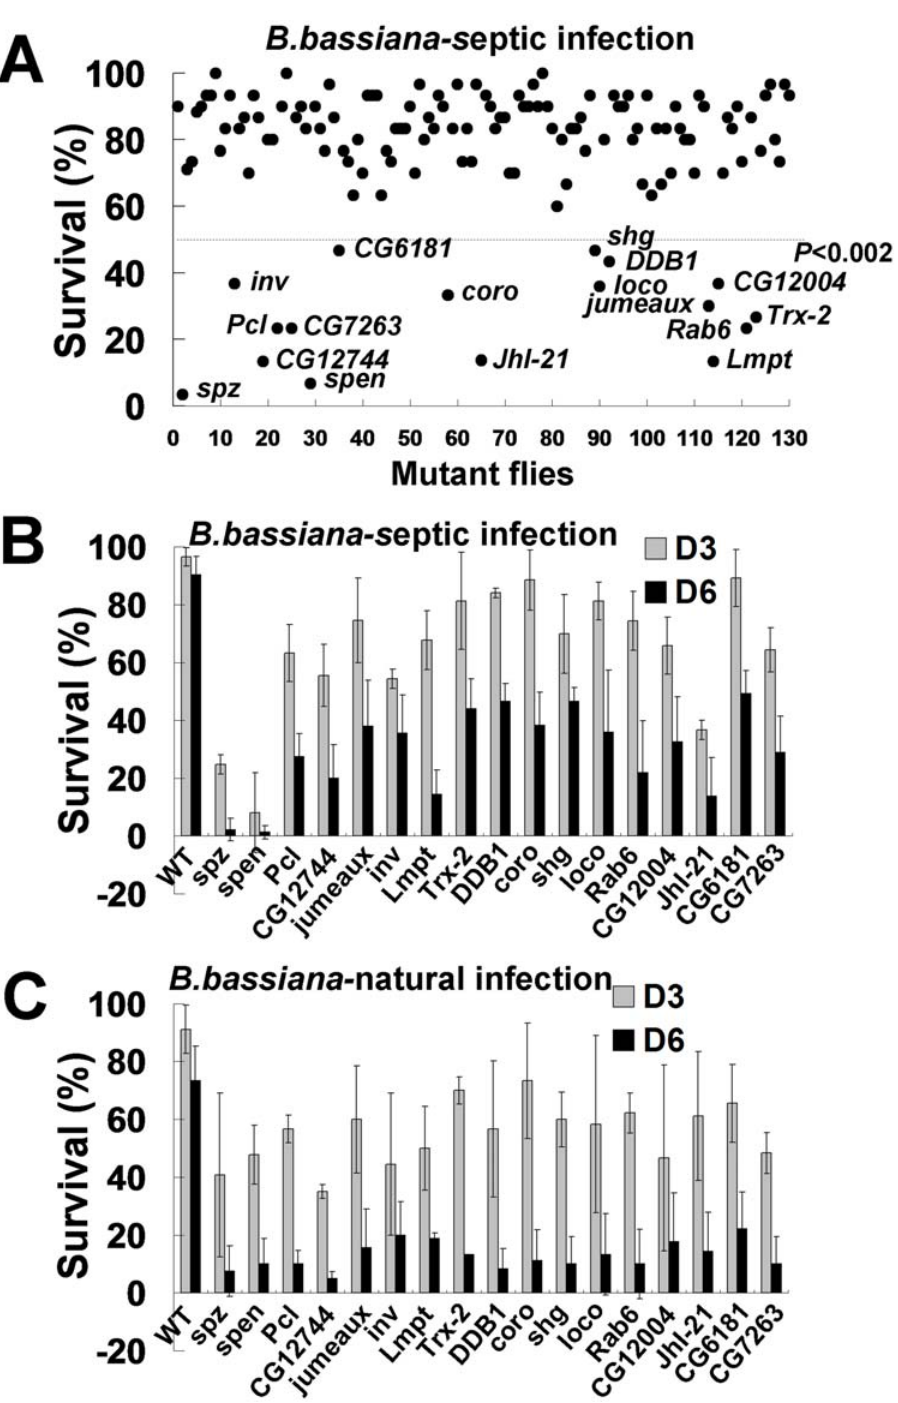
Figure 1. Screening of immune defective mutant flies. (A) The survival rate on day six after Beauveria bassiana ( B. bassiana ) septic infection is shown for the 130 mutant lines examined. Of 130 mutant lines, 16 had dramatically reduced resistance to B. bassiana infection, with a survival rate of less than 50% after six days ( p , 0.002). (B, C) Survival rate kinetics from three independent experiments are shown for the 16 mutants with increased sensitivity, (B) septic infection (C) natural infection. The spz rm7 mutant was used as a positive control for B. bassiana infection. WT is wild type, and D3 and D6 stands for the survival at day 3 and day 6, respectively, post-infection.